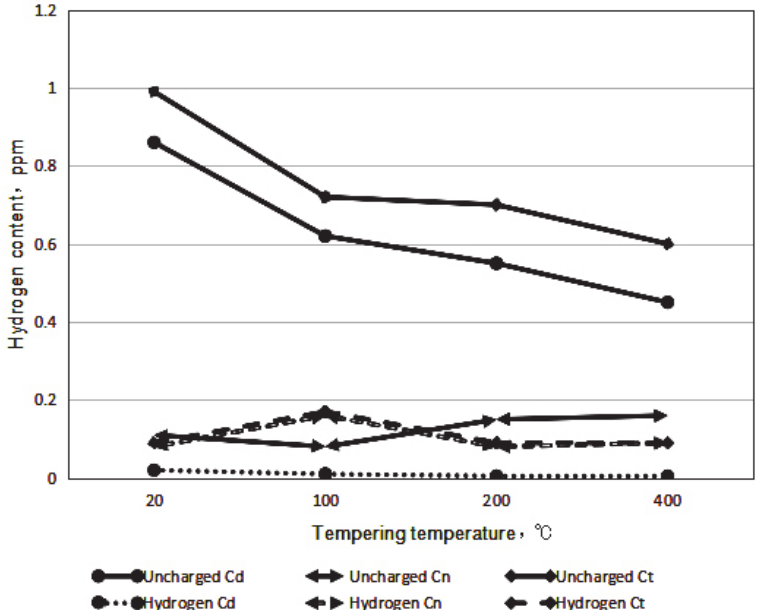
Figure 6: Vibration of the content of hydrogen of round bar samples in different states before and after hydrogen charging (C d : the content of diffusible hydrogen; Cn: the content of non-diffusible hydrogen; Ct: the content of